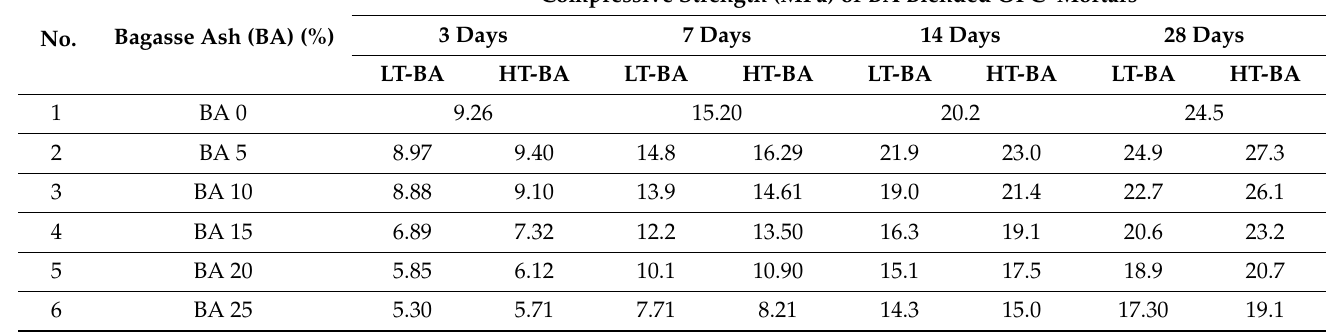
Table 4. Compressive strength of bagasse ash (HT–BA and LT–BA) blended OPC mortar samples. BA amount from 0 to 25% of cement replacement.